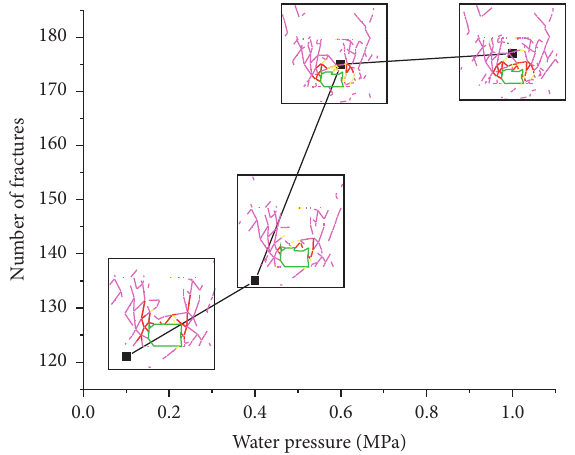
Figure 11: Roadway fracture